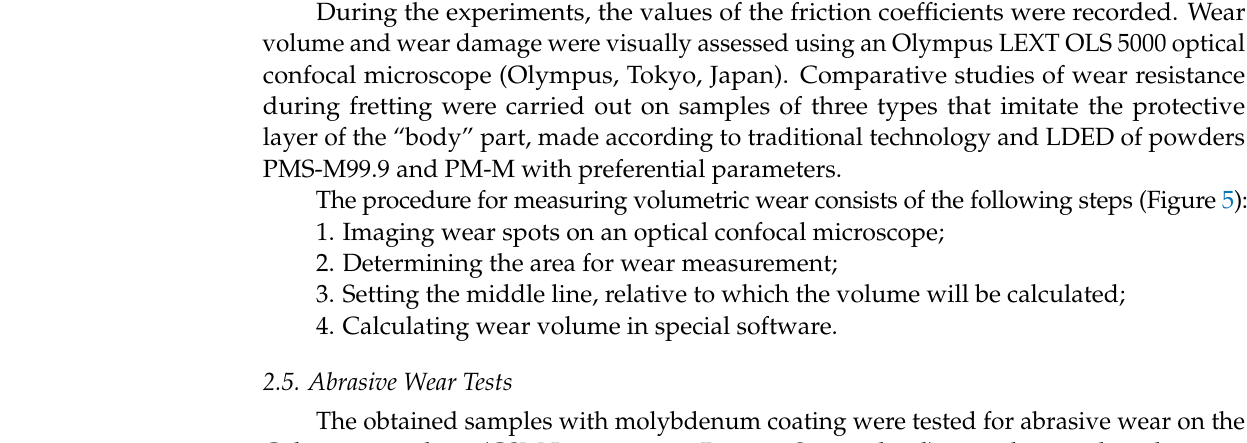
Table 4. Fretting wear tests conditions.